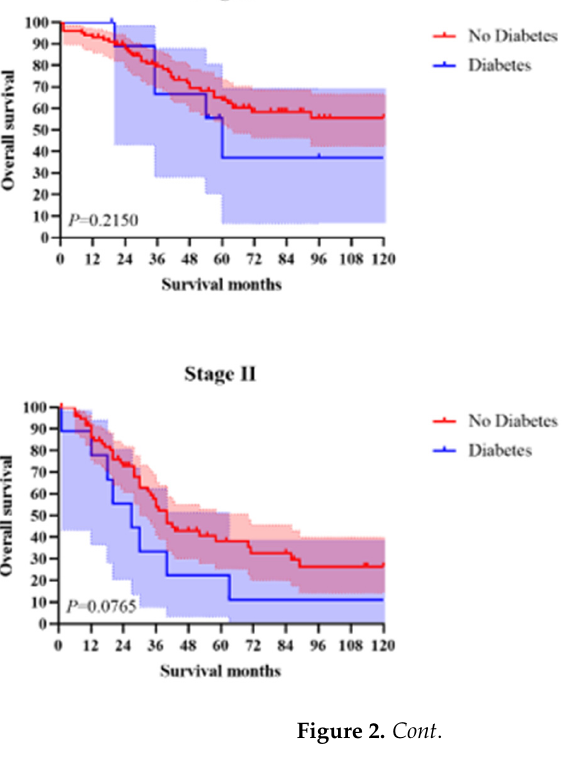
Figure 1. Comparing the survival curves for OS and RFS between the diabetes group and the no diabetes group of AC patients.